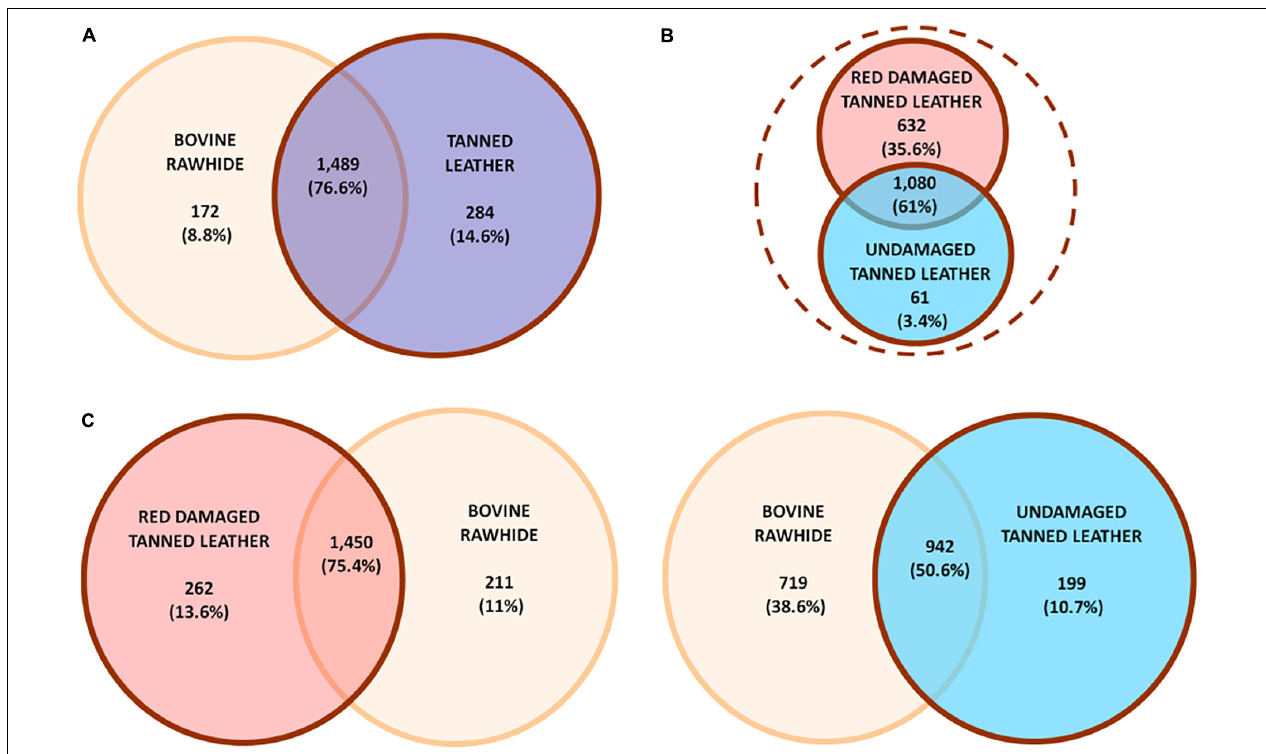
FIGURE 3 | Unique or shared OTUs in (A) comparison between bovine rawhides (BRHs) (orange) and tanned leather samples (blue), these last included both red damaged (DTL) and undamaged tanned leathers (UTL); (B) comparison within tanned leather sample subset: DTL (red) vs. UTL (light blue); ( C , left) comparison between DTL (red) and BRHs (orange); ( C , right) comparison between BRHs (orange) and UTL (light blue). Number and percent of OTUs are